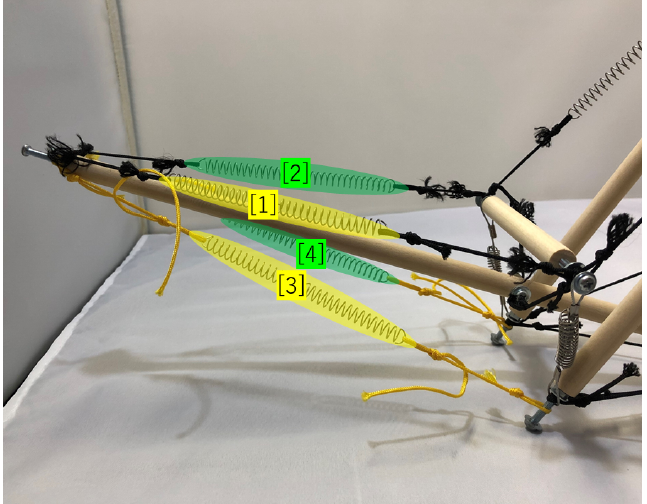
Figure 6. The numbers of the tensile members in the upper arm. In this figure, the tensile member inside the elbow at the front of the upper arm is No. 1; the member inside the elbow at the back is No. 2; the member outside the elbow at the front is No. 3; and the member outside the elbow at the back is No. 4. They are color-coded yellow and green to make them easier to